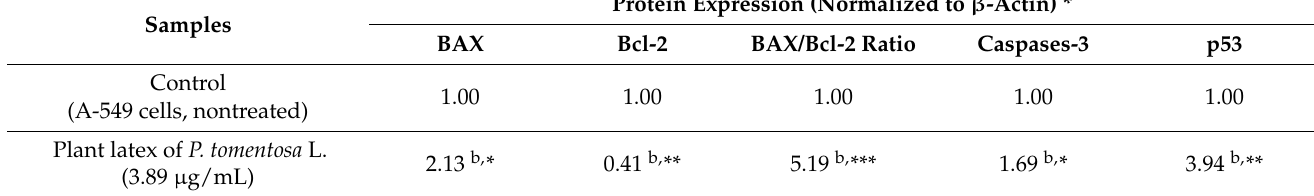
Table 3. The effect of the IC 50 of the plant latex of P. tomentosa L. on the expression of the apoptotic protein expression of Bcl-2, Bax, caspase-3, and p53-mediated apoptosis in lung cancer cell lines (A-549) a .